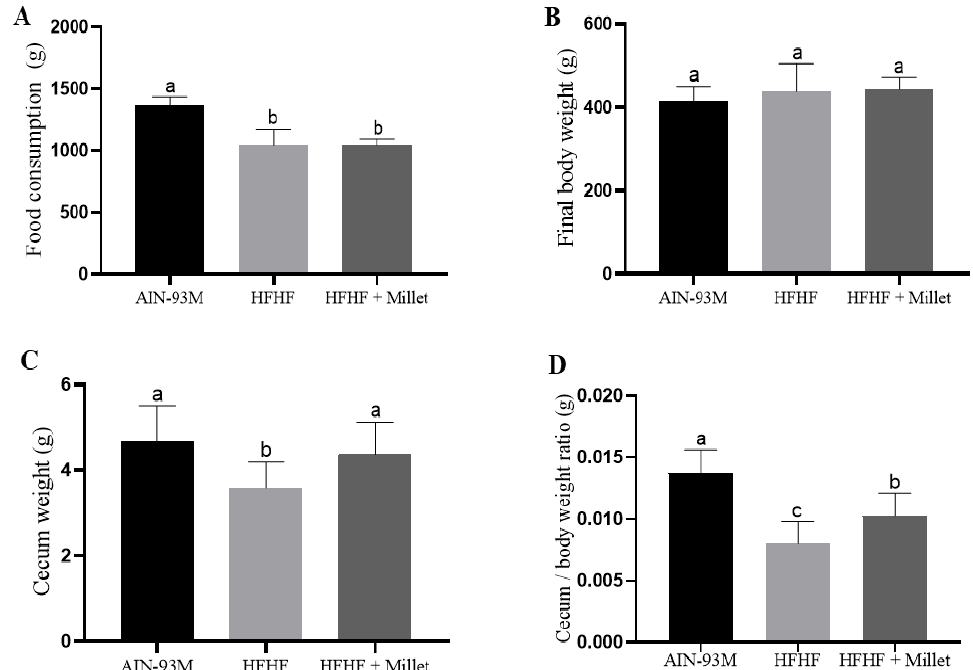
Figure 1. Effect of germinated millet flour on food consumption ( A ), body weight ( B ), cecum weight ( C ), and cecum/body weight ratio ( D ), after 10 weeks of intervention. Columns with different letters indicate significant differences by one-way ANOVA and post hoc of Newman–Keuls test ( p < 0.05). Values are presented as means and standard deviation (n = 10/group). AIN-93M: standard diet; HFHF: high-fat high-fructose diet; HFHF + millet: HFHF diet + 28.63% of germinated millet flour. Table 1. Effects of germinated millet flour intake for 10 weeks on intestinal health in Wistar rats (n = 8).